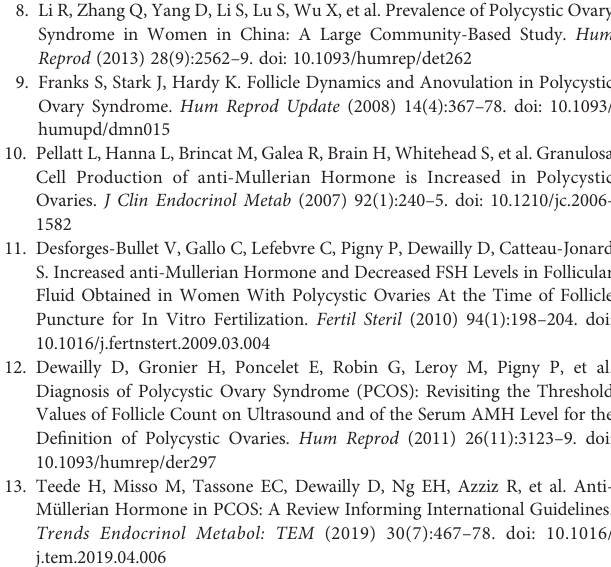
Supplementary Table 1 | Clinical data of patients in different age